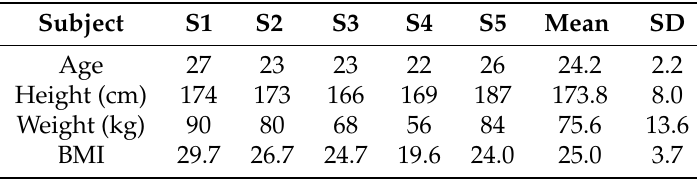
Table 1. Anthropometric information of experimental subjects.